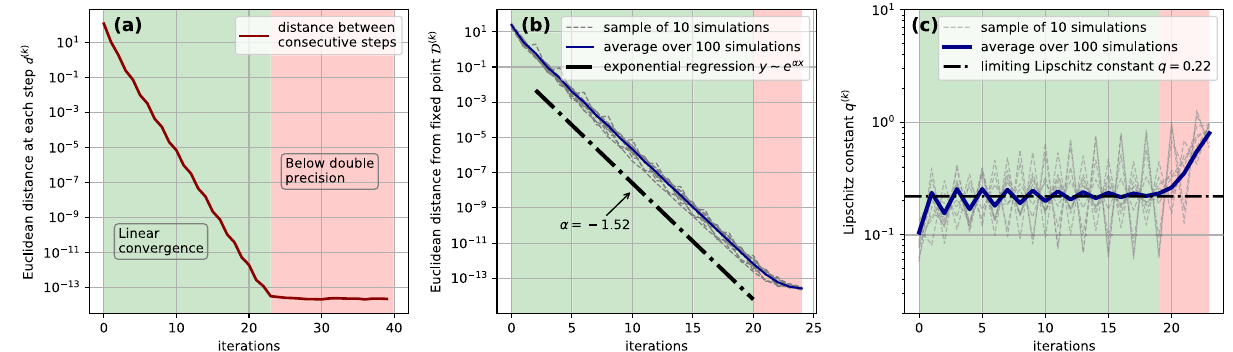
Figure 3. Convergence of the iterative scheme ( a ) Euclidean distance d ( k ) evaluated between consecutive steps of the iterative algorithm of Eq. (4). It clearly exhibits linearly fast convergence (green area of the plot), while after 23 iterations double precision limit is reached (red zone in the plot). ( b ) Euclidean distance D ( k ) from the fixed point of 100 iterations initiated with random initial conditions. Linear convergence to the same fixed point is observed, proving its uniqueness and global convergence of the algorithm. ( c ) Evaluation of the Lipschitz constant q as the ratios of distances from the fixed point of consecutive iterations. A sample of the 100 iterations starting from random initial conditions are colored in grey, whereas in blue we see the average performed over the whole data sample. The dashed black line represents the estimation of the Lipschitz constant obtained by the regression illustrated in the previous